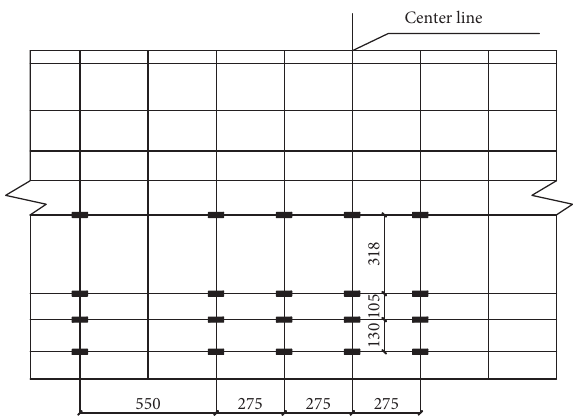
Figure 13: Layout of PLG-2 reinforcement measuring point (unit: